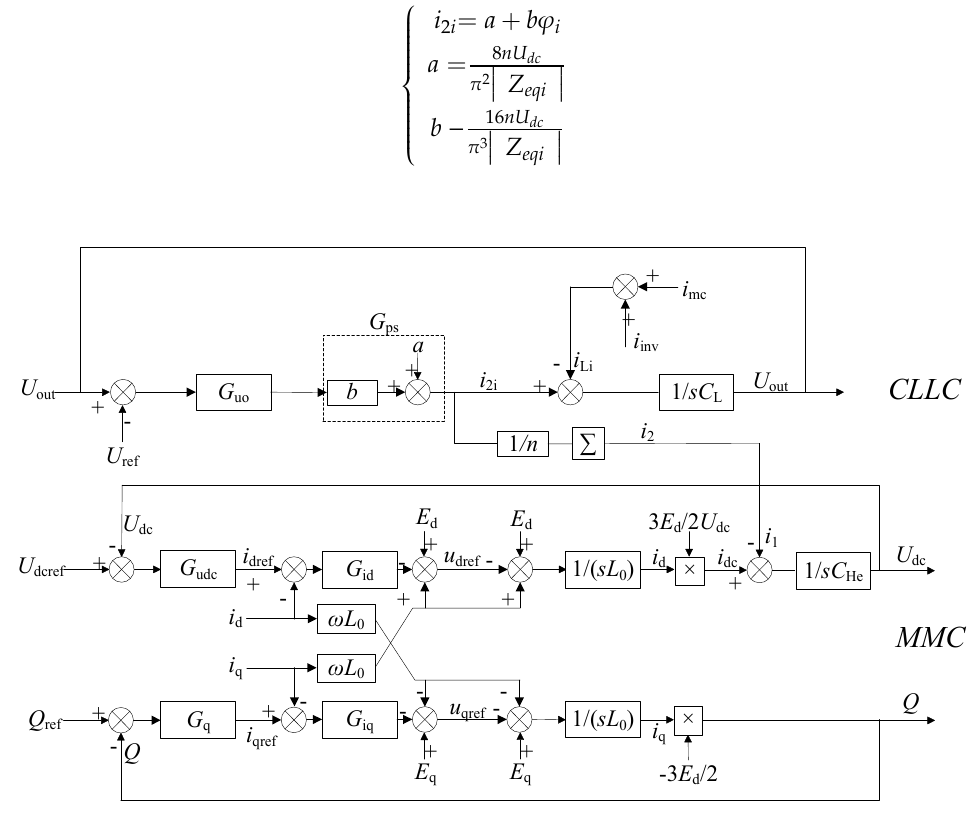
Figure 5. The independent control strategy of the SST.